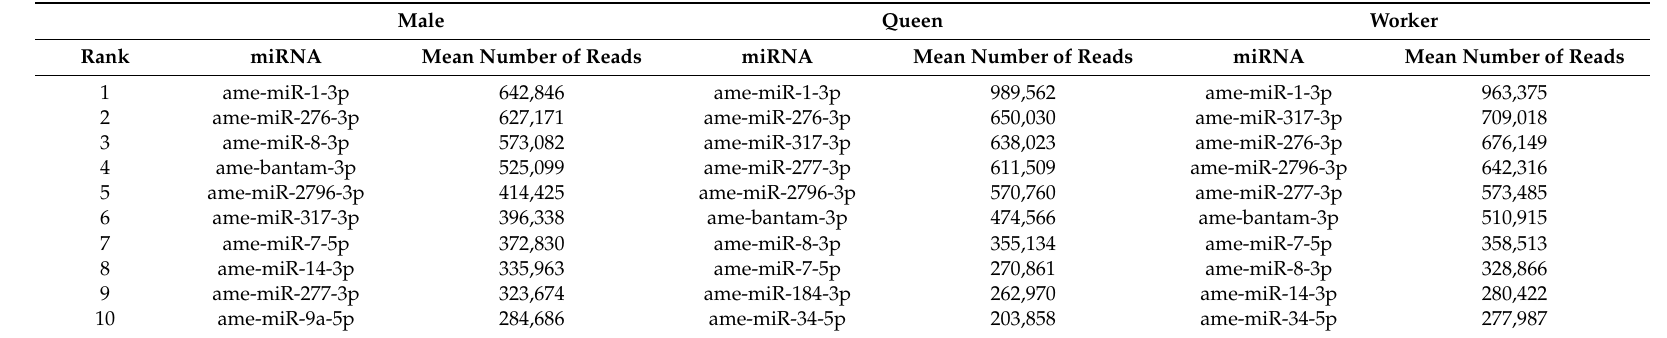
Table 3. Ten most abundant miRNAs in the three castes of B. lantschouensis